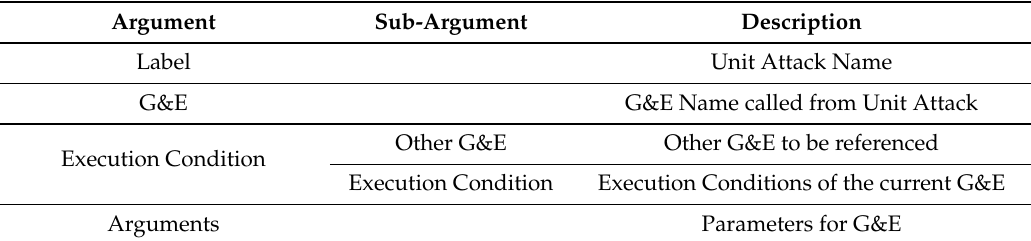
Table 3. Components of the unit